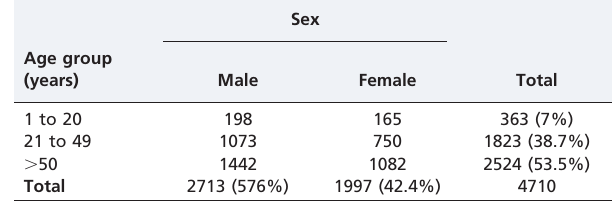
Table 1 - The demographic analysis by sex and age of the patients with acute respiratory failure who underwent